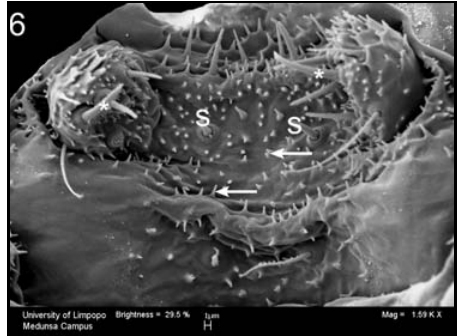
Fig. 6. The pair of labial palpi with numerous spiked or spinous setae (arrows) and two well developed larger sensory setae (s), which are raised at their bases. The tips of the palpi bore three larger and longer sensory setae